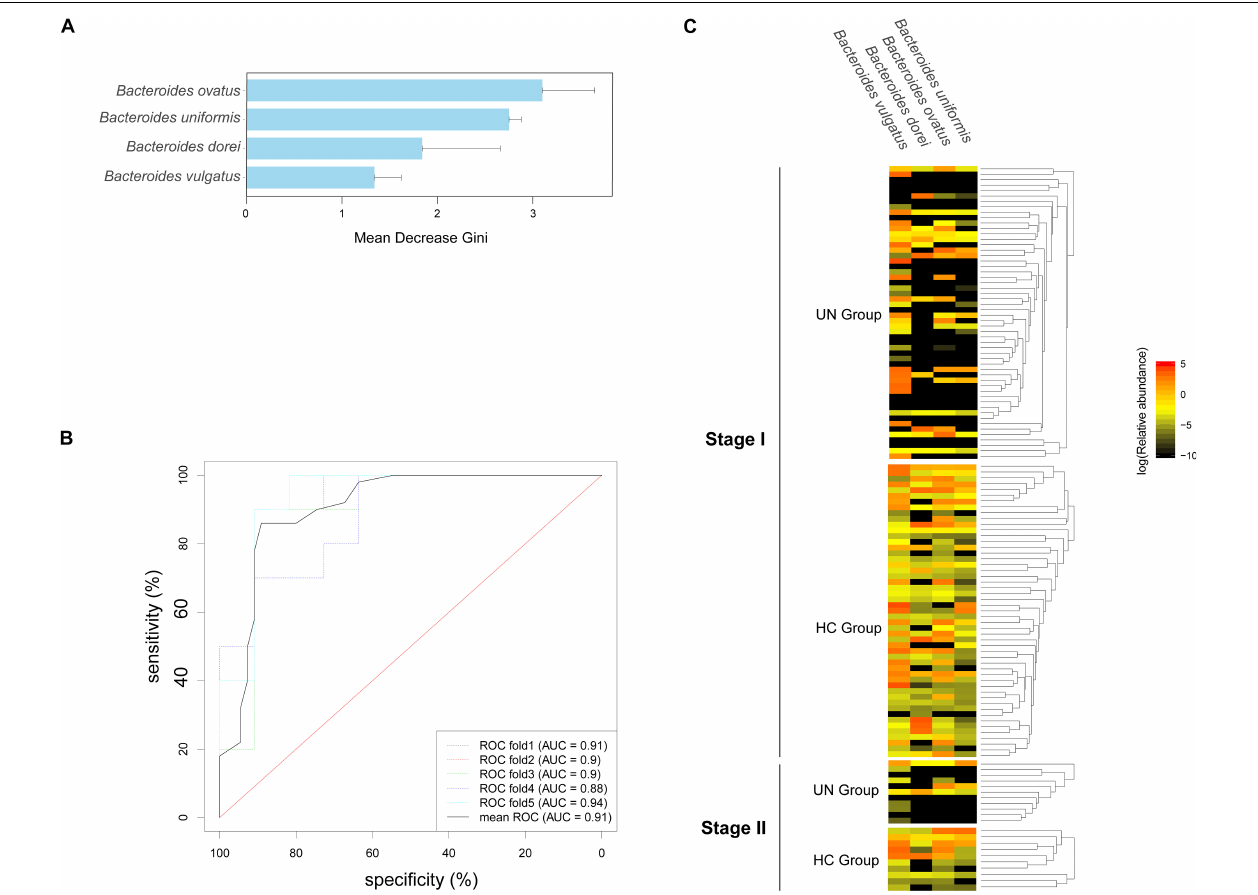
FIGURE 4 | Species markers and their accuracy in differentiating the UN group from the HC group. (A) Four species were identified for the optimal classification of the HC and UN children at stage I; the Gini values are plotted. (B) The accuracy of the species markers was evaluated by using the samples from stage II, and ROC curves were drawn with five repeats in different colors along with AUC values. (C) The relative abundances of the biomarkers in all samples are shown with a heatmap.